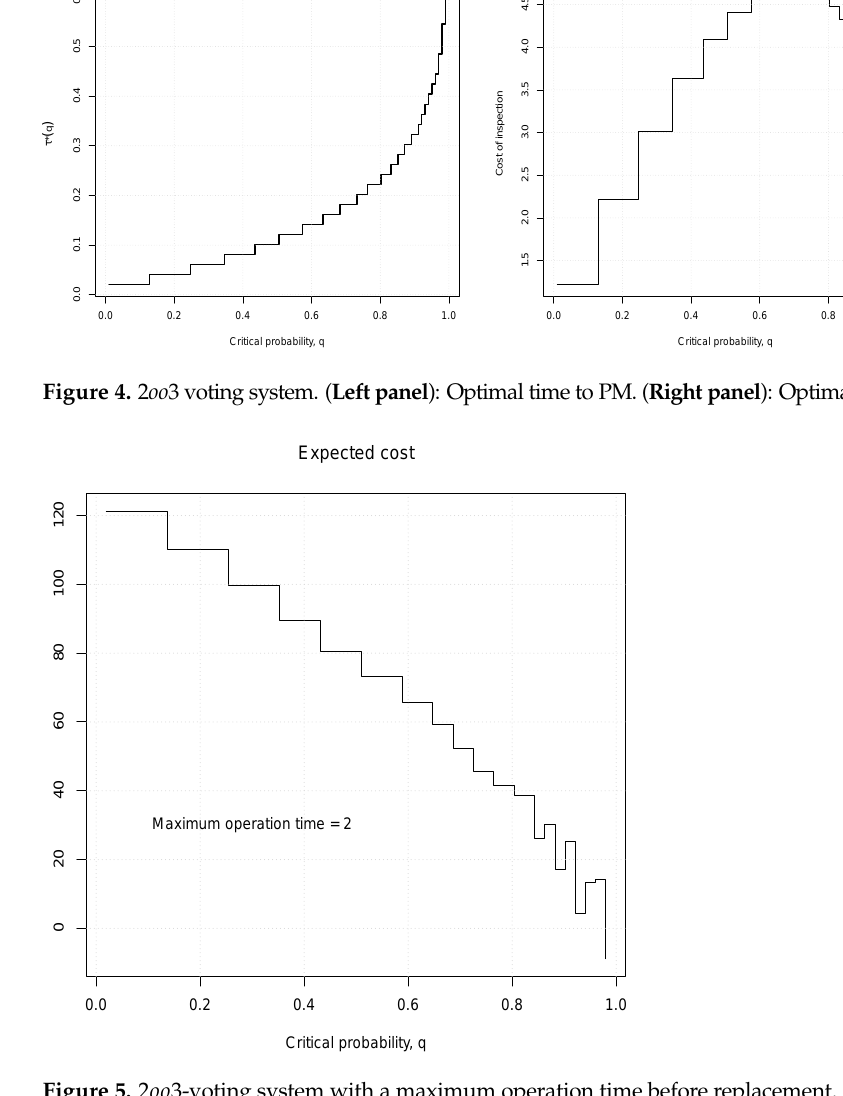
Figure 5. 2 oo 3-voting system with a maximum operation time before